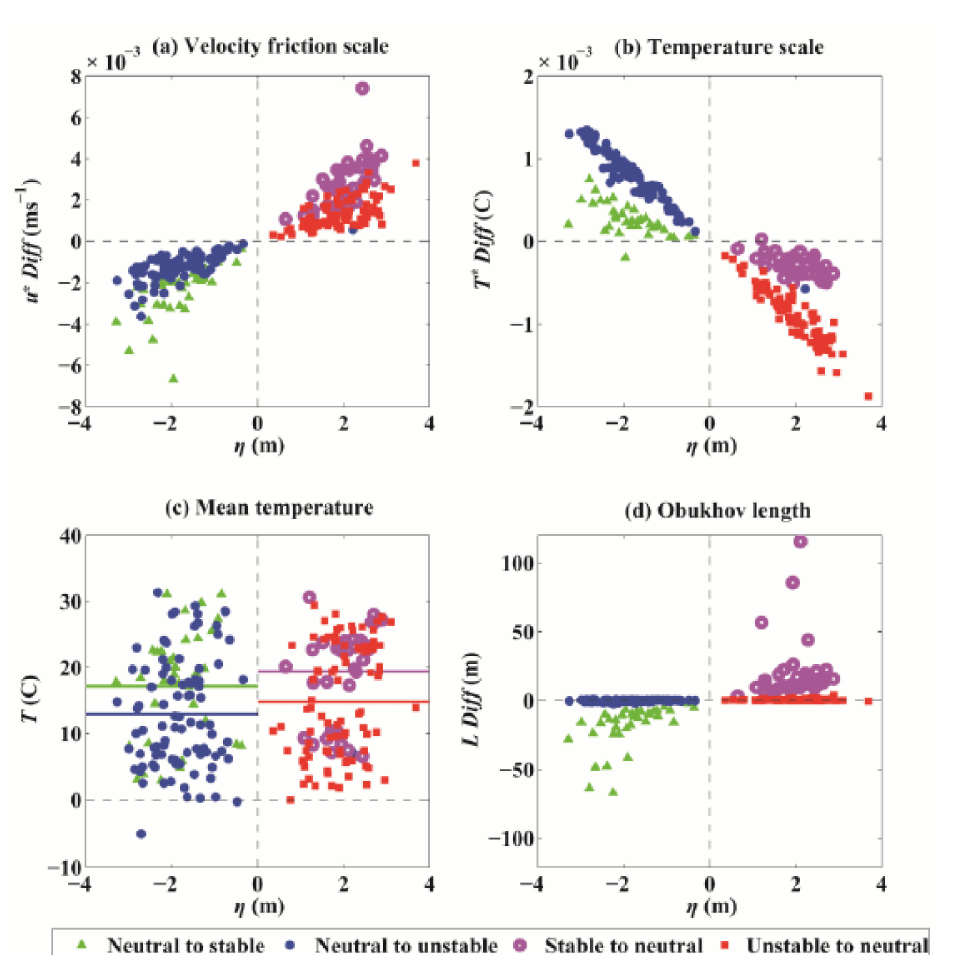
Figure 10. Scatter plots of hourly differences in frictional velocity ( u* , ms − 1 , ( a )) and temperature scale ( T* , C, ( b )), mean temperature ( T , C, ( c )), and Obukhov length scale ( L , m, ( d )) between magnitudes with and without the inclusion of SSE ( η , x-axis). The ensemble mean temperature in ( c ) is plotted by solid lines with the same colours as the scatters. Changes in the state of the BLS are marked by different colours and symbols. Green triangles and blue dots represent shifts from near-neutral conditions ( − 0.4 < ξ < 0.1) to stable ( ξ > 0.1) and unstable ( ξ < − 0.4) conditions, respectively, while magenta circles and red squares represent shifts from the stable and unstable boundary conditions to near-neutral conditions, respectively.